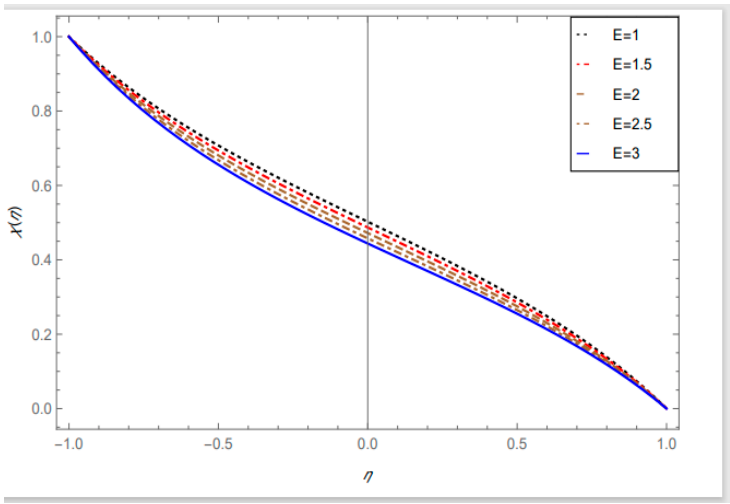
Figure 6: Dimensionless activation energy parameter effect on the concentration profile at 𝑎 = −2 , 𝑅 (cid:3032) = −0.5, 𝑃𝑟 = 6.2 .